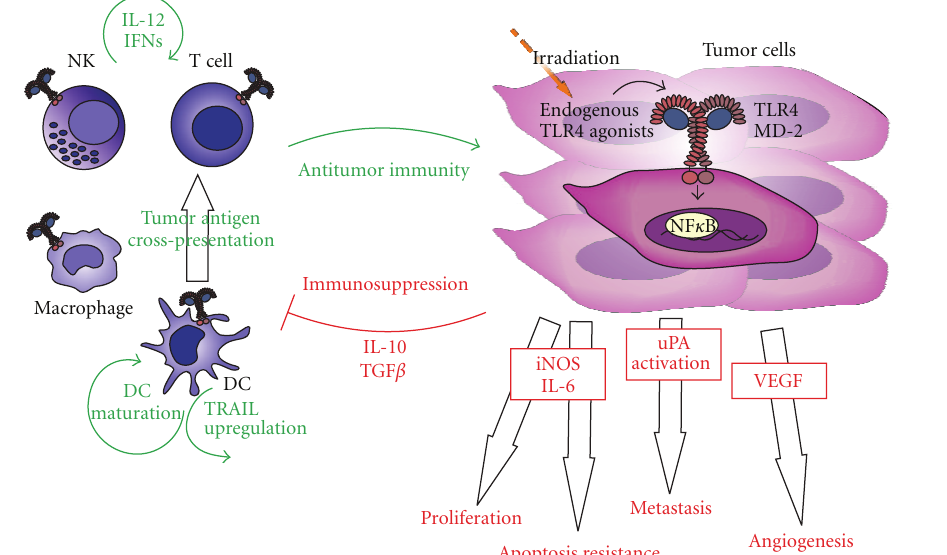
Figure 2: TLR4 signaling in cancer—a struggle of antitumor immunity against cancer proliferation and immune evasion. TLR4 signaling on immune cells can enhance anti-tumor immunity by di ff erent mechanisms, including IL-12 or IFN γ upregulation and promotion of DC maturation and function (left side of the figure, depicted in green). On the other hand, TLR4 signaling on tumor cells can increase their tumorigenic potential (right side of the figure, depicted in